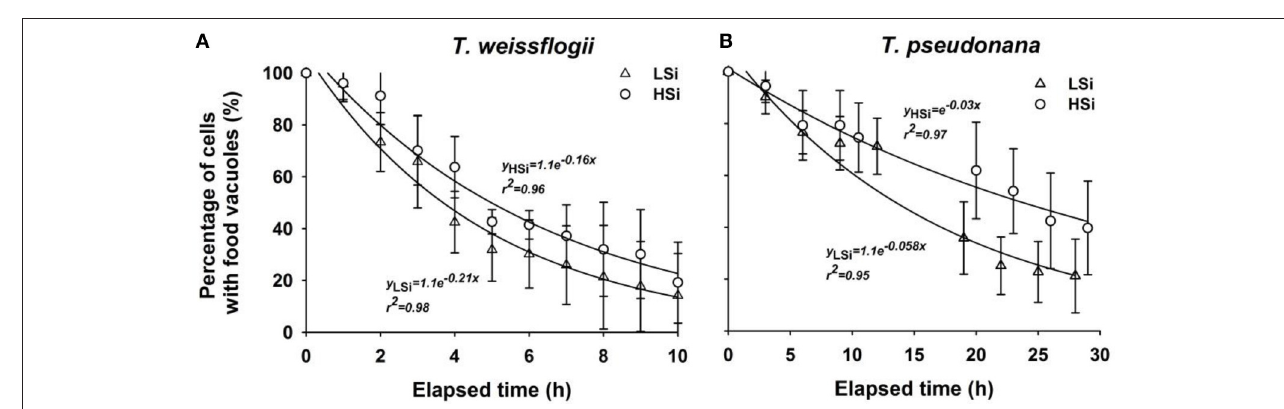
Frontiers in Marine Science |